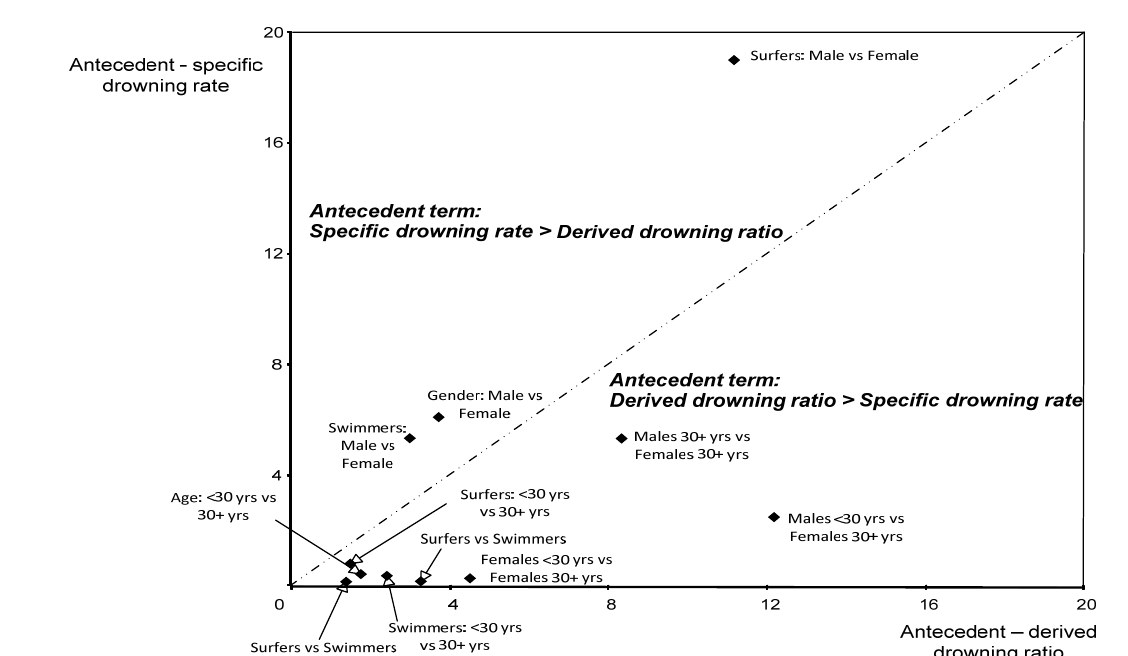
Table 5. Summary results for comparison between derived drowning ratio and specific drowning rate for subgroups within risk marker groups.